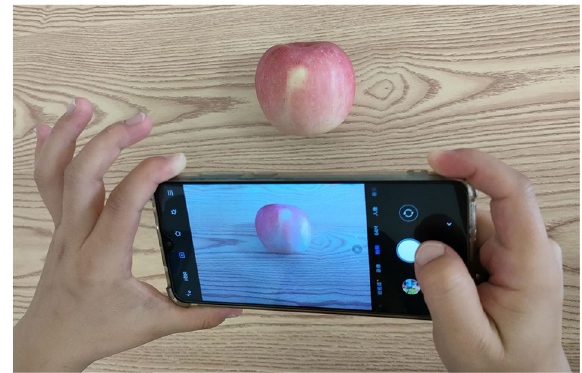
Figure 1. The process of images capturing using mobile